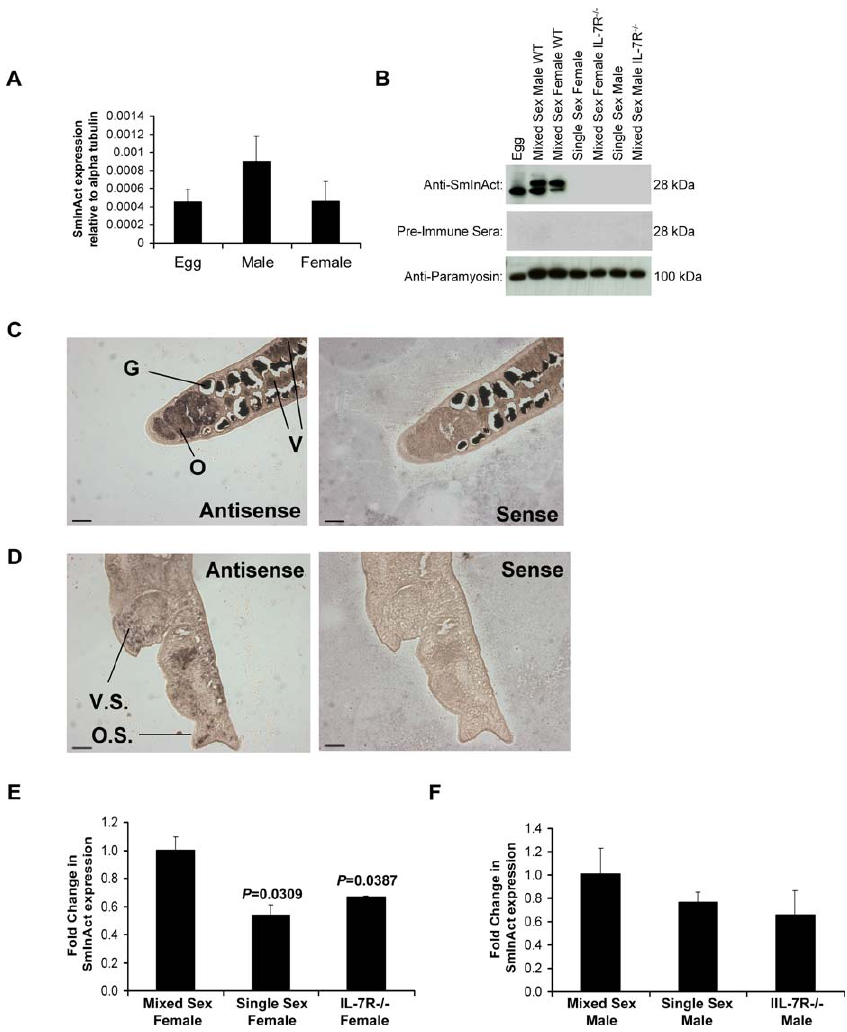
Figure 2. SmInAct Expression Is Linked to Reproductive Capability (A) SmInAct is expressed in the egg, adult male, and adult female. The RNA tested is indicated on the x -axis, and the y -axis represents the ratio of SmInAct cDNA relative to a -tubulin cDNA (reference gene), as determined by real time RT-PCR. Data are presented as mean ratios ( þ / (cid:2) standard deviation [s.d.]) from three separate experiments. There is no significant difference in SmInAct expression among the stages tested. (B) SmInAct protein is detectable in eggs, adult males, and adult females from mixed-sex infections in wild-type mice, but is not detectable in females or males from single-sex infections, or in females or males from mixed-sex infections of IL-7R (cid:2) / (cid:2) mice. (C) SmInAct transcript is localized to the reproductive tissues of the adult female, including the ovary (O) and vitellaria (V) (left panel, in situ hybridization with anti-sense probe) A serial section was probed with sense-strand SmInAct and over-developed (right panel). G, gut. Scale bar ¼ 110 l m. (D) SmInAct transcript is localized to subtegumental regions of the adult male, with concentrations of expression around the oral sucker (O.S.) and ventral sucker (V.S.) (left panel, in situ hybridization with anti-sense probe). A serial section was probed with sense-strand SmInAct and over-developed (right panel). Scale bar ¼ 110 l m. (E) SmInAct mRNA levels are significantly lower in females isolated from single-sex infections or from IL-7R (cid:2) / (cid:2) mice than in females isolated from infected wild-type mice. SmInAct mRNA levels were measured by real-time RT-PCR. Data are presented as mean fold change in expression ( þ / (cid:2) s.d.) from two RNA extractions. (F) SmInAct mRNA levels in males isolated from single-sex infections or from IL-7R (cid:2) / (cid:2) mice compared to mRNA levels in wild-type mice. SmInAct mRNA levels were measured by real-time RT-PCR. Data are presented as mean fold change in expression ( þ / (cid:2) s.d.) from two RNA extractions. There is no significant difference in SmInAct expression in males from single-sex infections or from IL-7R (cid:2) / (cid:2) mice versus males isolated from mixed-sex infection of wild-type